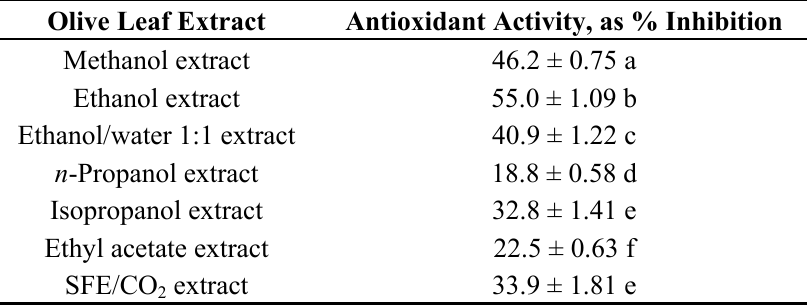
Table 3. Antioxidant activity of olive leaves extracts 1